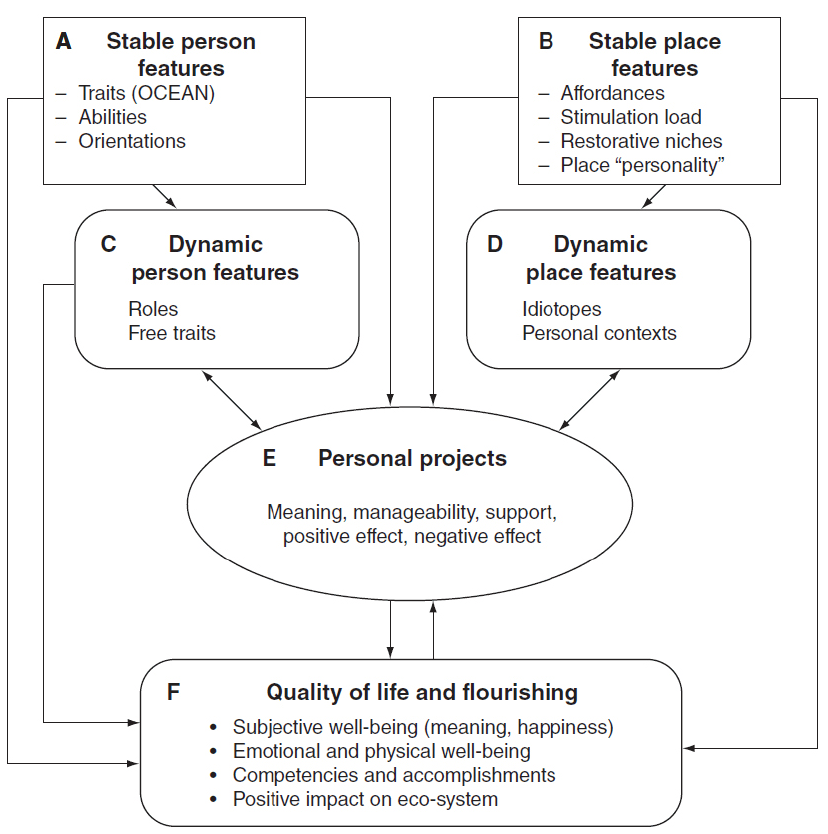
Figure 1. Social ecological framework for measuring human flourishing (reproduced, with permission from Brian Little